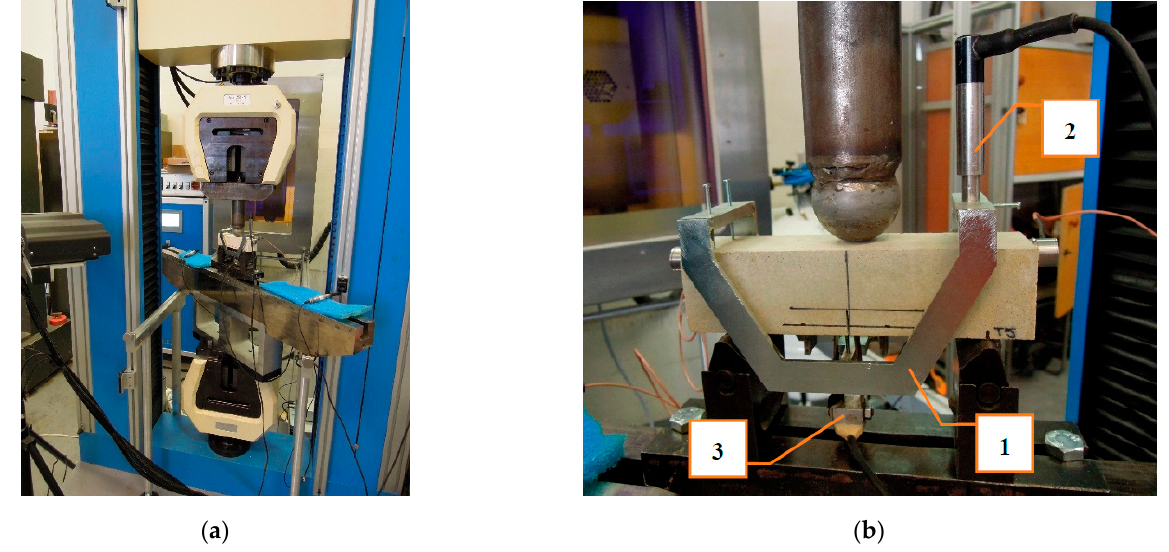
Figure 4. Arrangement of static fracture test ( a ), fracture test configuration in three-point bending (3PB) ( b ) including the measurement frame (1), and the sensors for measuring the midspan deflection (2) and the crack mouth opening displacement (3).